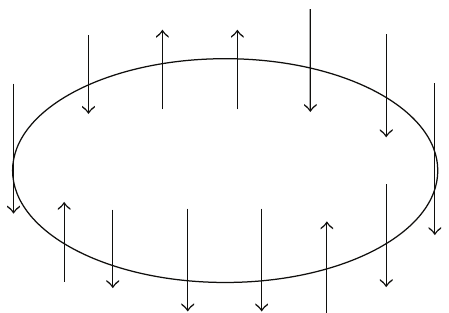
Figure 2: Example of a spin chain. The “up” arrow represents the field Z , while the down spin is represented by the field W